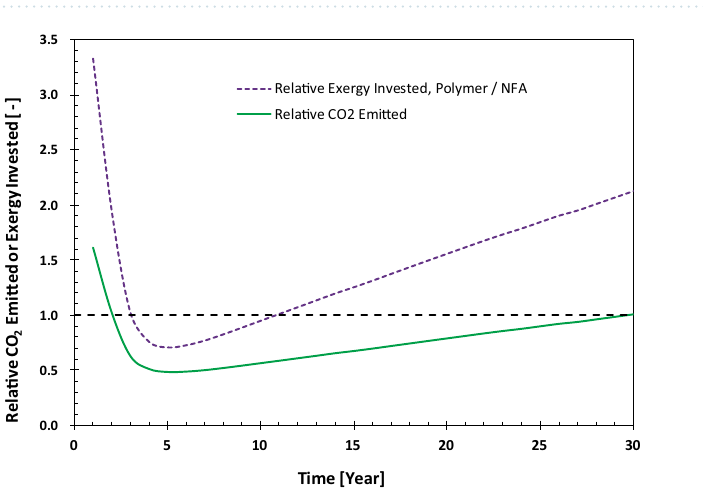
Figure 6. Fractions of exergy invested and CO 2 emission at different time intervals for water and polymer injection cases.